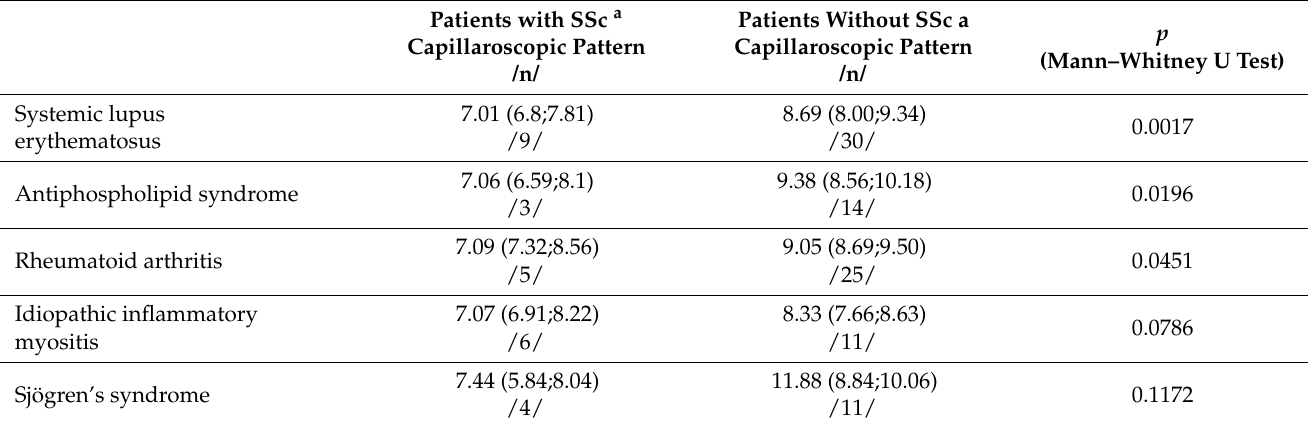
ROC Curve; AUC = 0.953